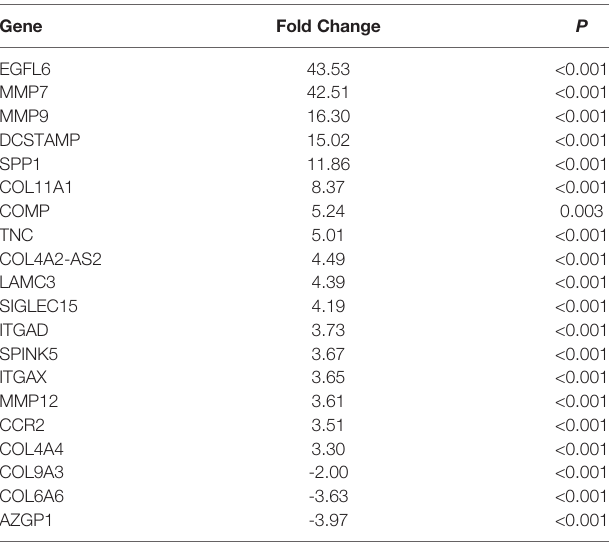
TABLE 3 | The top differentially expressed genes associated with tissue structure and remodelling in scWAT in individuals living with obesity at study entry (week 0).